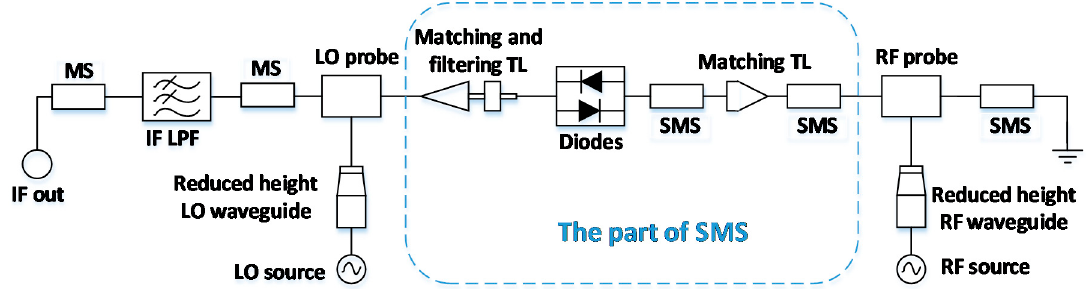
Figure 2. The model of terahertz sub-harmonic mixer based on the half-global design method (HGDM).